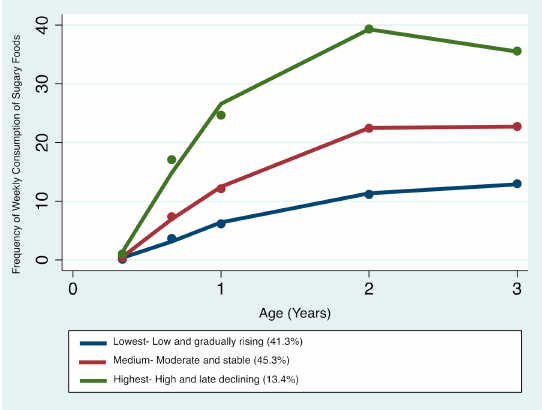
Figure 3. Trajectories of sugary foods consumption in infancy and early